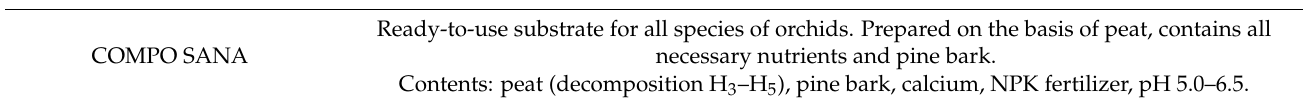
Table 9. Features of the substrates used during the acclimatization of Paphiopedilum insigne plantlets to ex vitro conditions. Substrate for Orchids COMPO